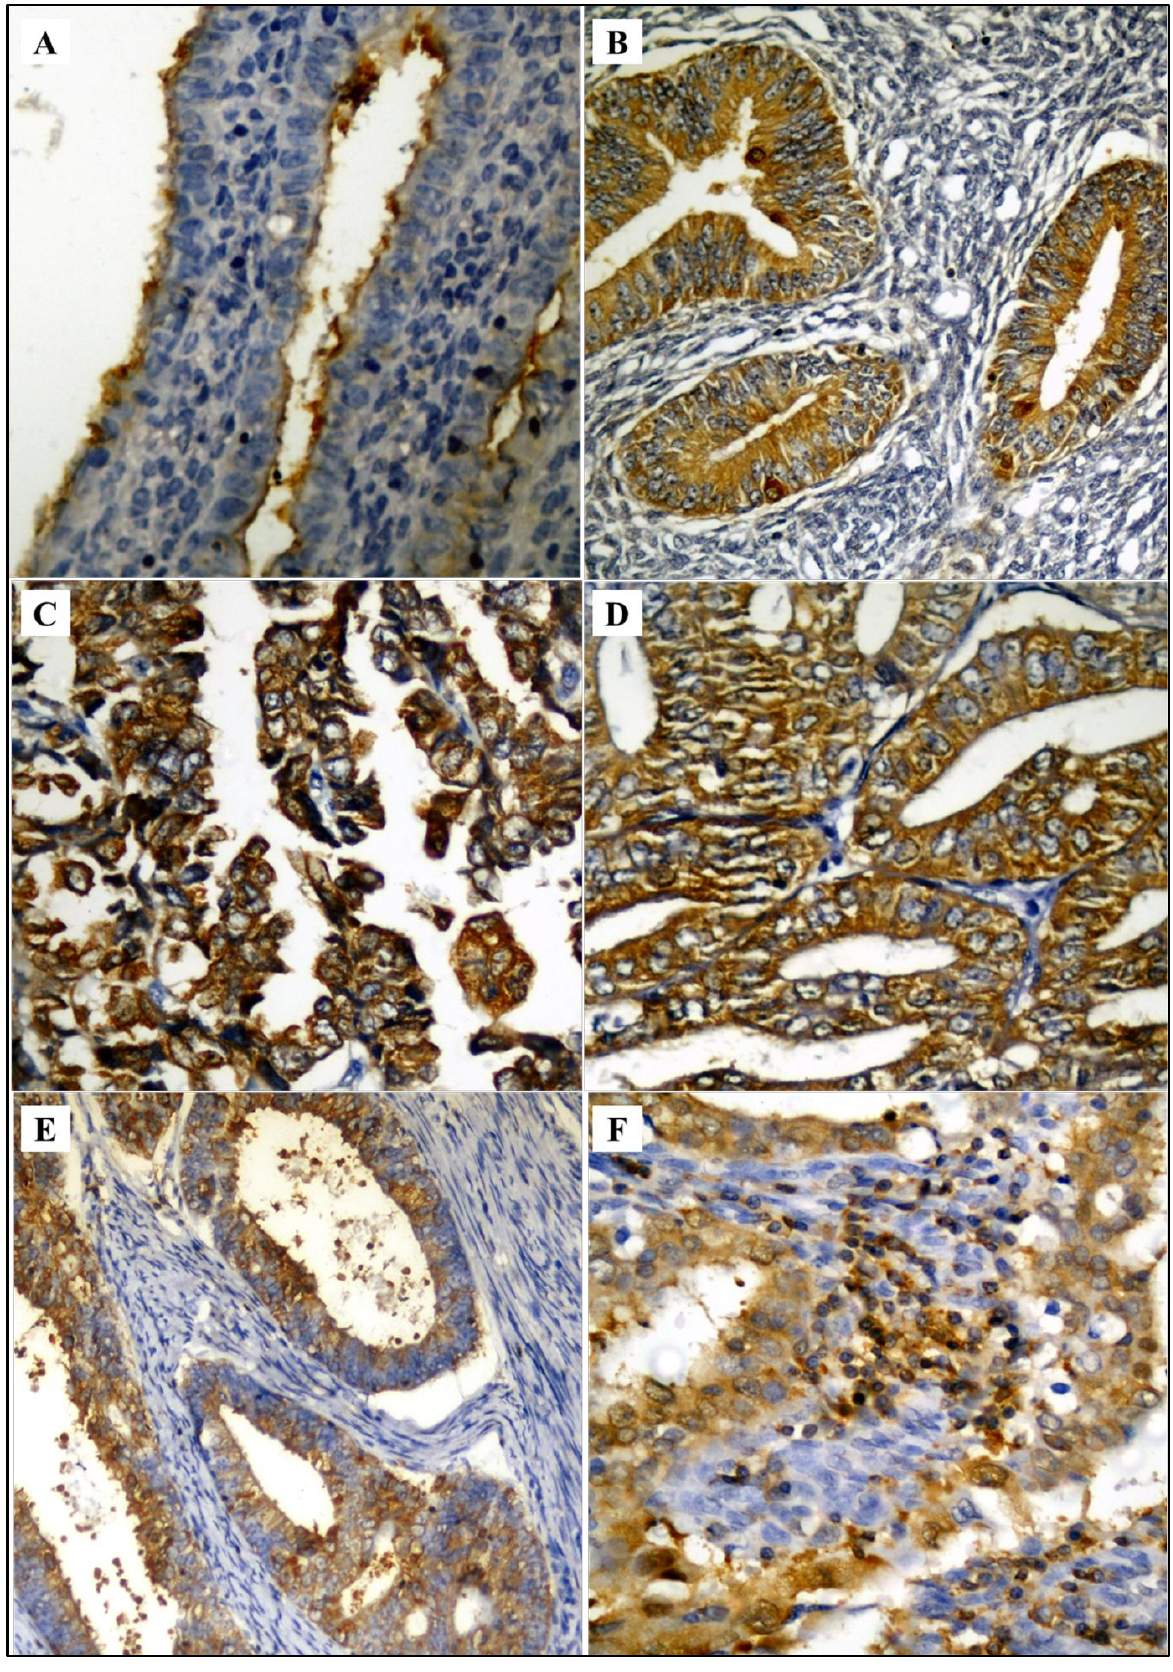
Figure 1: Membranous expression of ezrin in simple endometrial hyperplasia (A, x400) versus membrano-cytoplasmic expression in atypical endometrial hyperplasia (B, x400), villoglandular carcinoma (C, x400) and endometrioid carcinoma (D, x400). Ezrin is strongly expressed by invasive glands (E, x200) and by tumor-infiltrating lymphocytes (F,